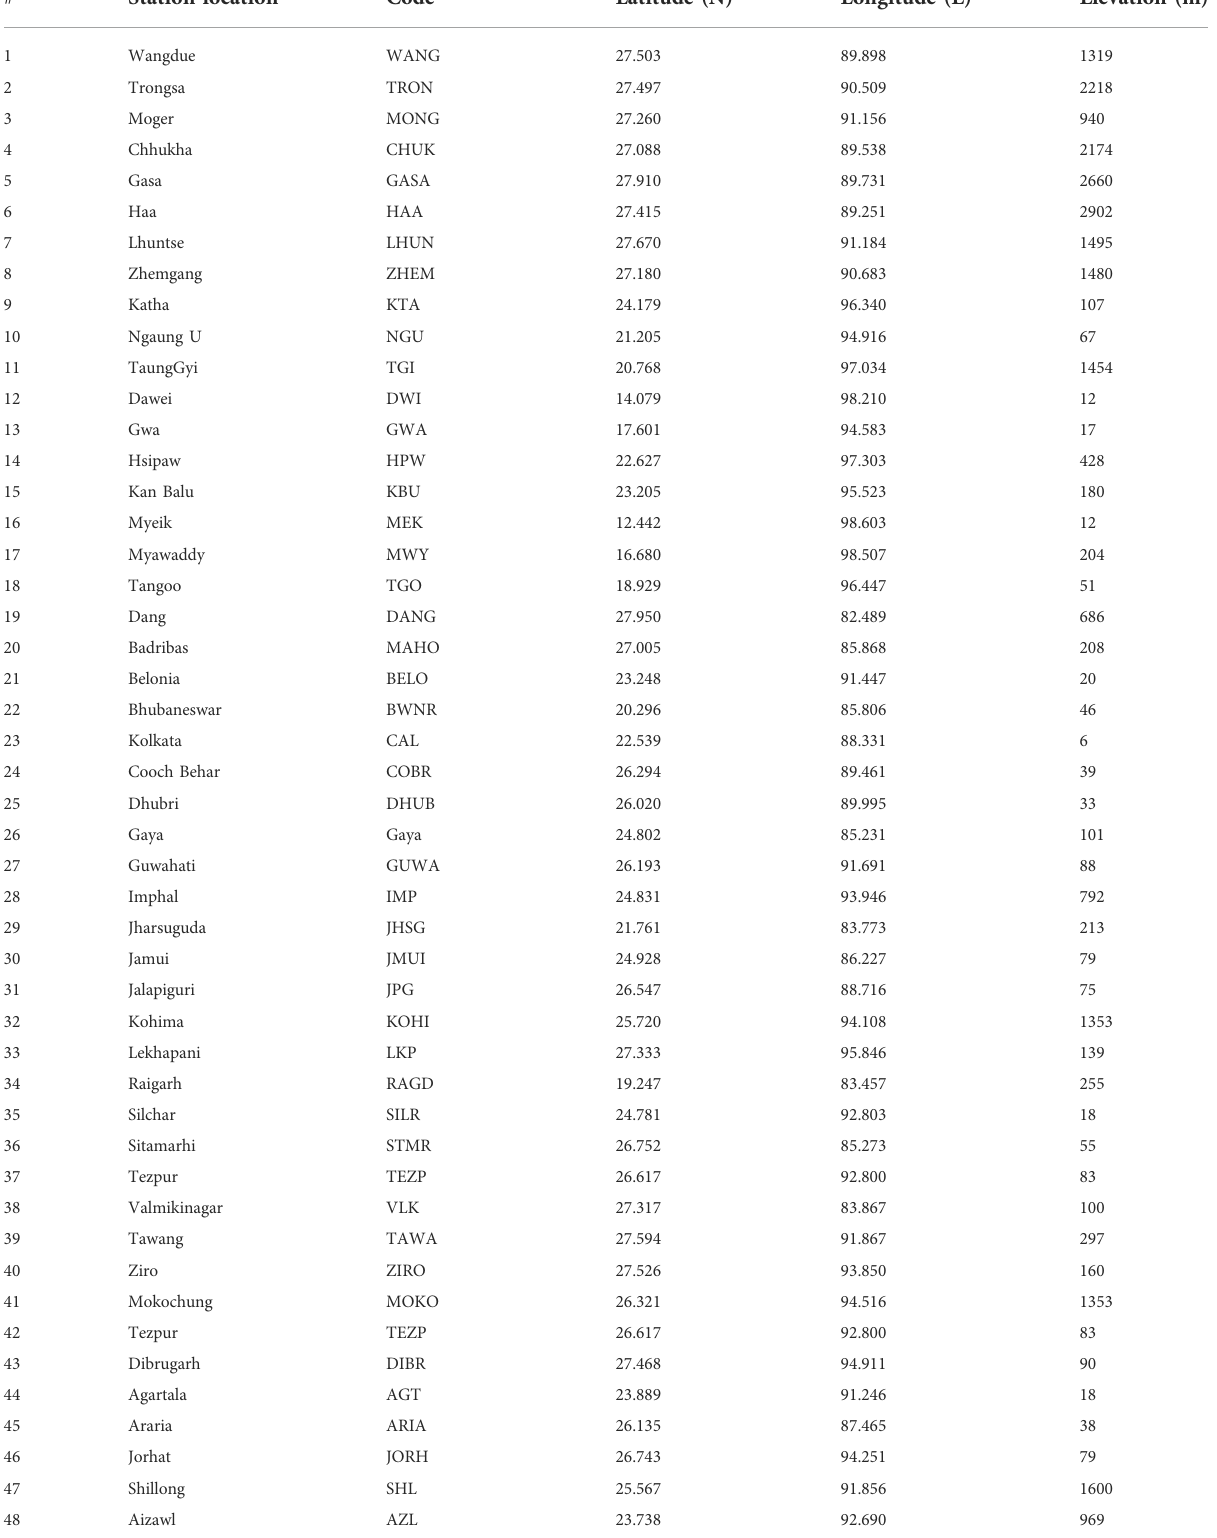
TABLE 1 Details of the location of seismic stations used in the present